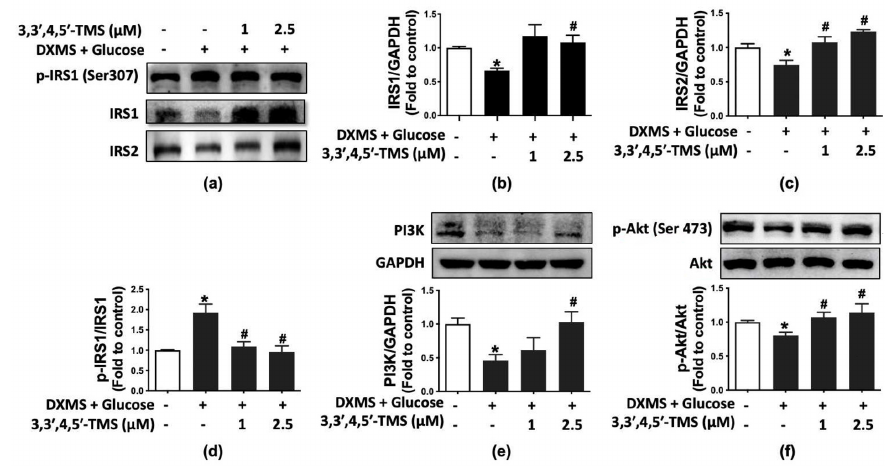
Figure 3. The effects of 3,3 (cid:48) ,4,5 (cid:48) -TMS on IRS/PI3K/Akt signaling pathways. ( a ) Representative West- ern blots and summarized data for protein expressions of ( b ) IRS1, ( c ) IRS2 and ( d ) phosphorylated IRS1 at Ser307 in HepG2 cells with different treatments. ( e ) PI3K expressions and ( f ) phosphorylation of Akt at Ser473 in IR-HepG2 cells. Values are the means ± SEM ( n = 4); * p < 0.05 vs. Control; # p < 0.05 vs. DXMS + glucose.